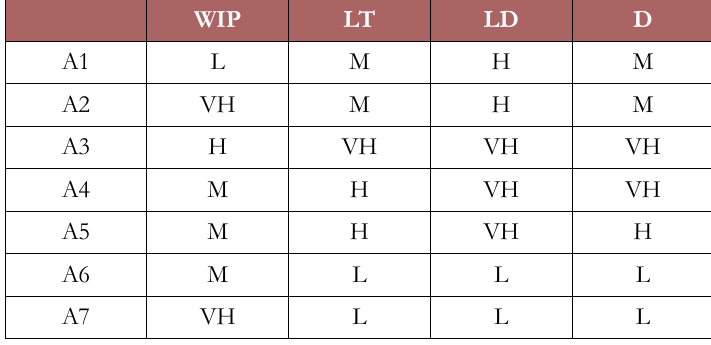
Table 7. Linguistic scale evaluation matrix for the